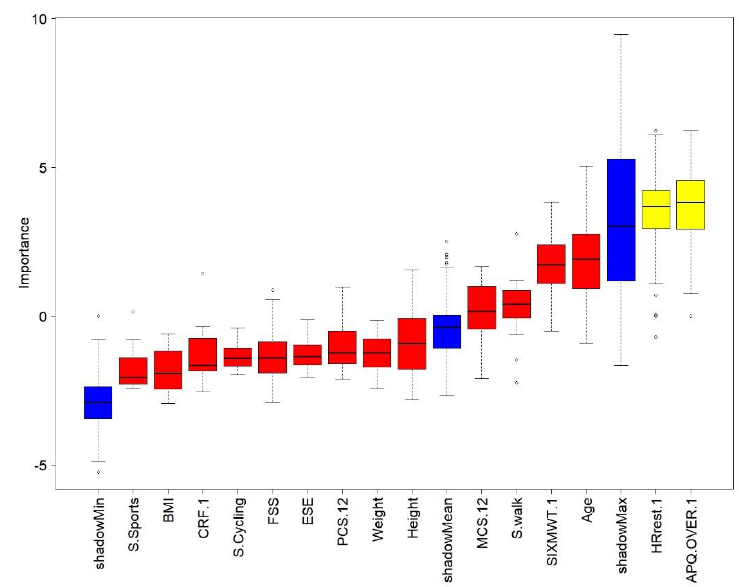
Figure 3. Recursive features elimination, exercise adherence. Red color means that the variable is not considered important in predicting exercise adherence. Yellow color means that the variable could be important in predicting exercise adherence; however, there is a degree of uncertainty left. Blue color distinguishes the randomized copy variables used to assess importance.